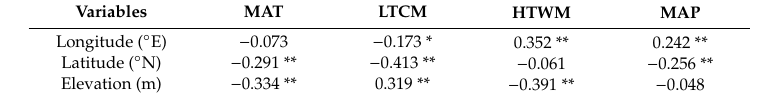
Table 4. Pearson correlations between site conditions and climate factors on a logarithmic (ln) scale. Variables MAT LTCM HTWM MAP Longitude ( ◦ E) − 0.073 − 0.173 * 0.352 **